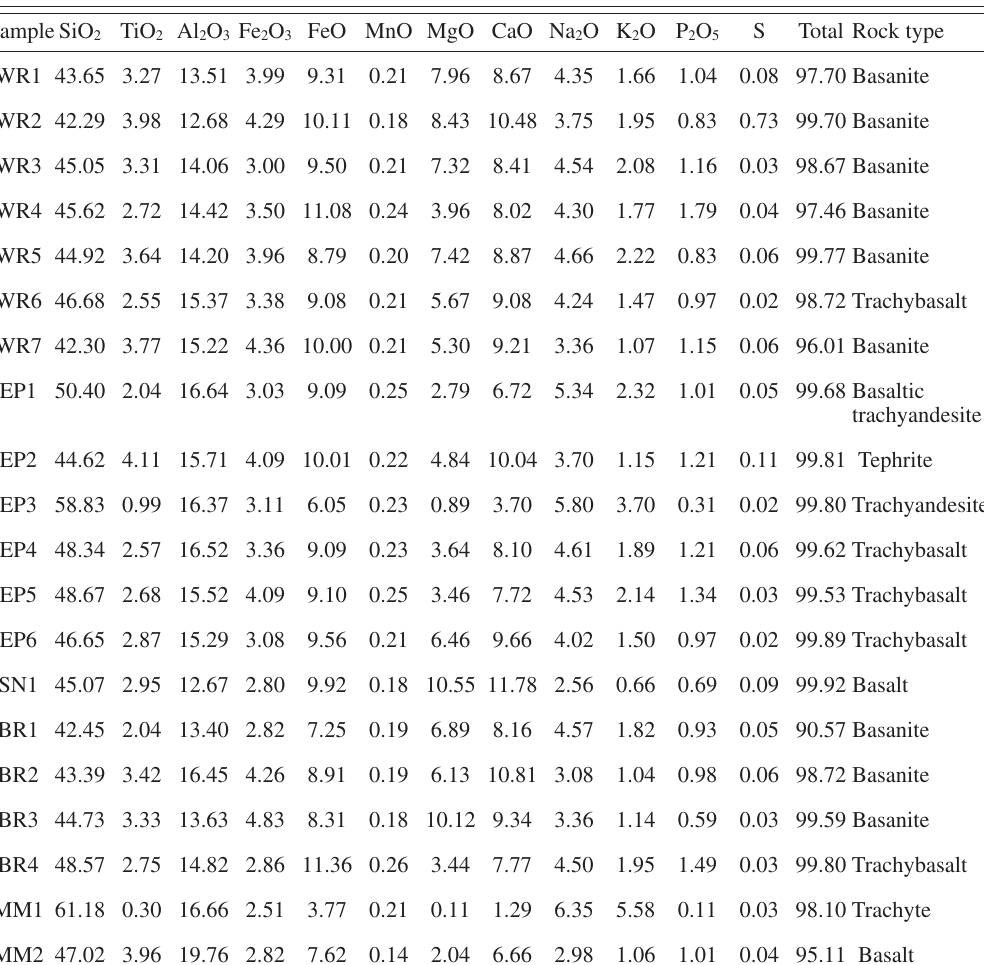
Table I. Chemical composition (in mass %) obtained from inductively coupled plasma mass spectrometry (ICP-MS) and rock type (see fig. 1 for sample